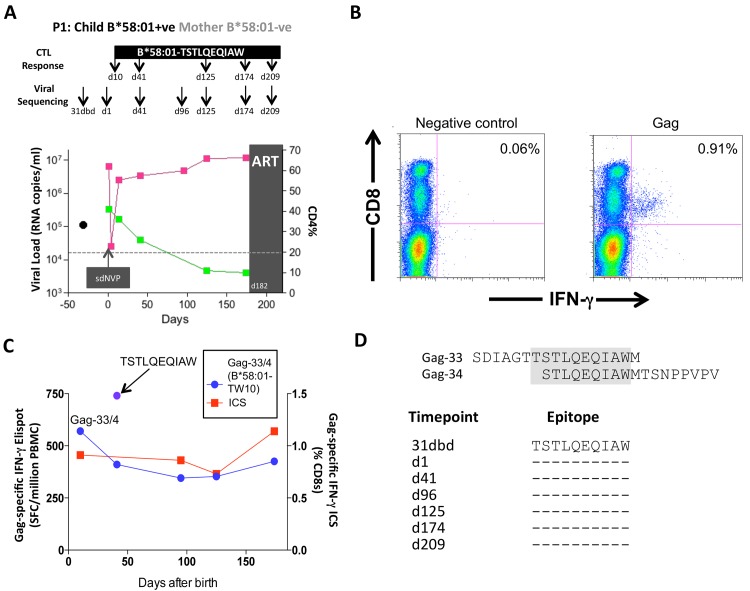
Gag-specific CD8+ T-cell responses and autologous viral sequences in a rapid progressing child, P1.A. Viral load and CD4% changes, CTL assays and viral sequencing timepoints. Closed red squares: viral load. Closed green squares: CD4%. Horizontal dotted lie: threshold for ART initiation (confirmed CD4<20%). Black closed circle: timepoint of maternal viral sequencing. Dbd: days before delivery. sdNVP: single dose nevirapine, given during labour and on the first day of life to the infant. D182: age of child at ART initiation. B. Gag-specific intracellular interferon-gamma staining assay undertaken when P1 was 10 days of age. C. Interferon-gamma elispot responses to Gag-33 and Gag-34 (two of 66 overlapping 18mers spanning the Gag protein), and on day 41 to the HLA-B*58:01-retricted Gag epitope TSTLQEQIAW contained within overlapping peptides Gag-33/4; and Gag-specific IFN-γ ICS data, showing responses to 66 pooled overlapping Gag peptides. D. Maternal viral sequence 31 days before delivery and autologous viral sequence in P1 showing lack of escape in all time points analyzed from day 1 to day 207, 25 days after ART initiation.